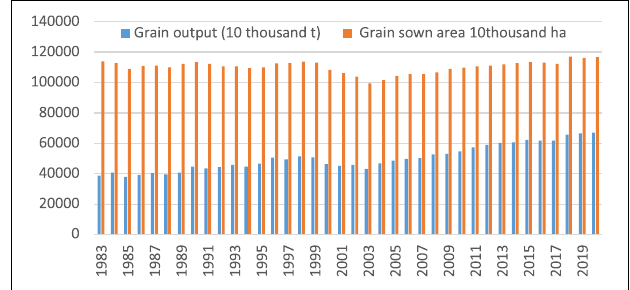
FIGURE 1 | China’s grain sown area and output,